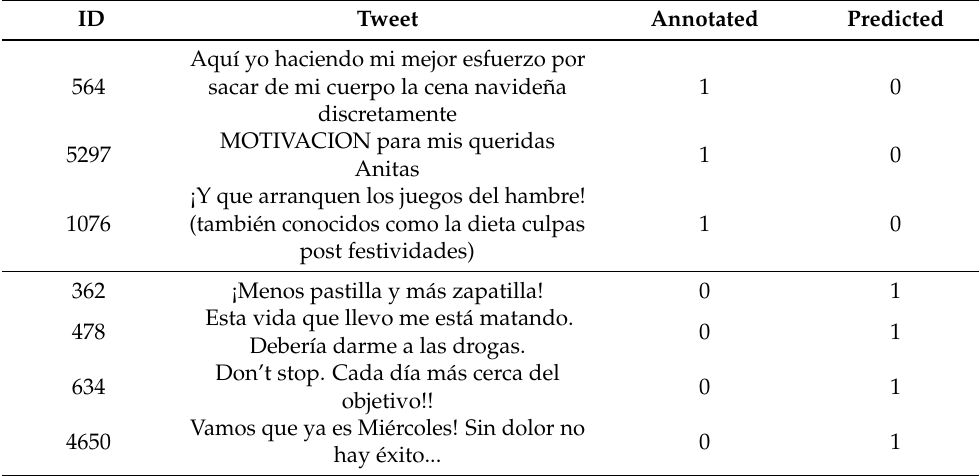
Table 4. Misclassified samples from SAD in Spanish.